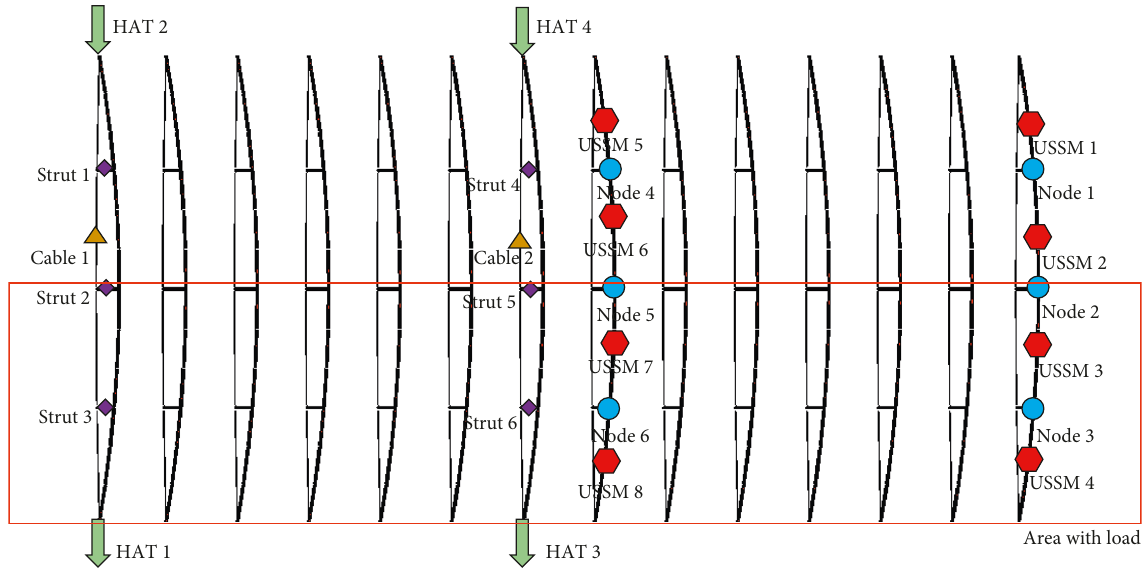
Figure 8: Targets in the numerical simulation analysis with a half-span load